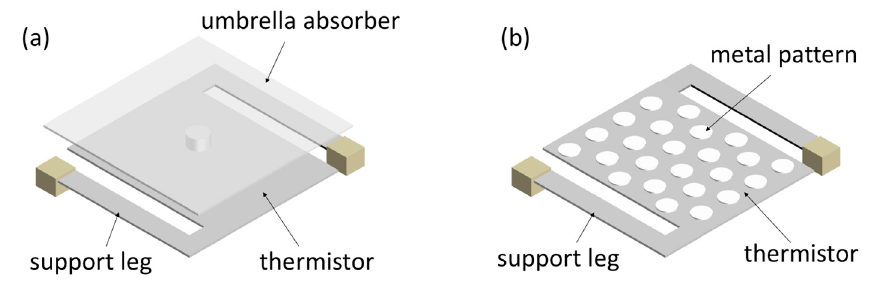
Figure 6. The schematics of a microbolometer with ( a ) umbrella absorber; ( b ) metasurface.